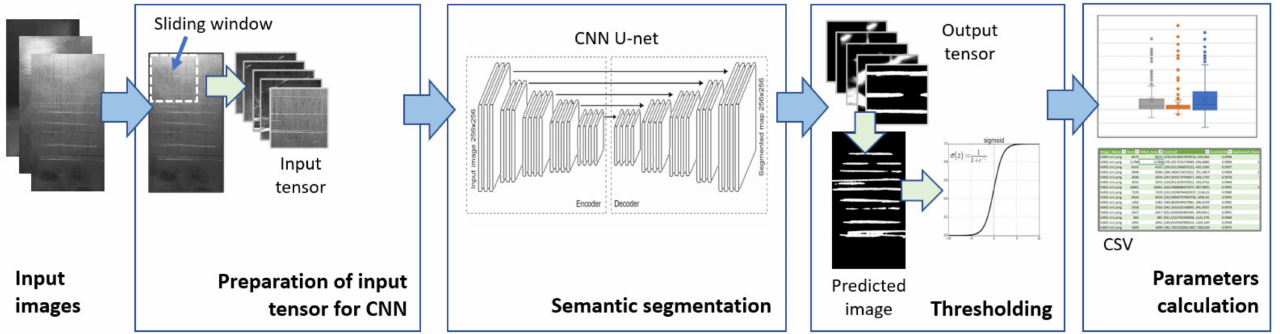
Figure 4. The general sequence of operations in the recognition of defects using the neural network in the image of any